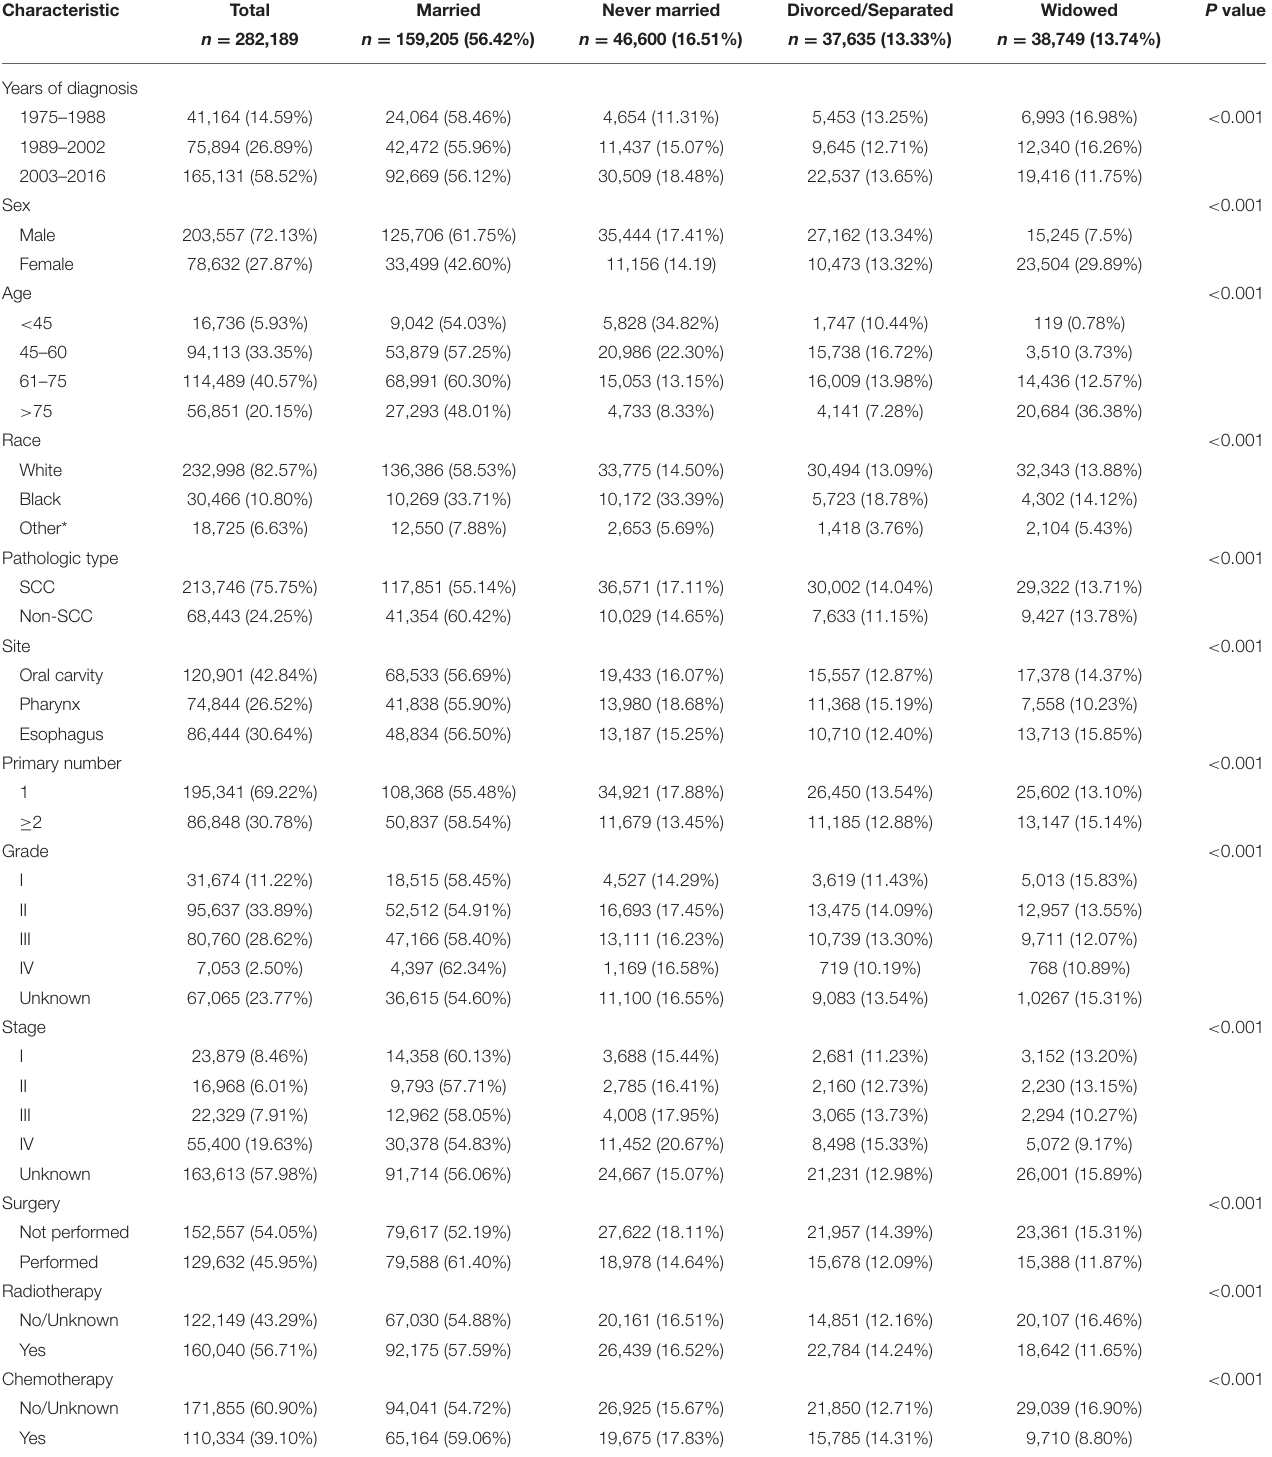
TABLE 1 | Demographic characteristics for patient cases with UDTT by marital